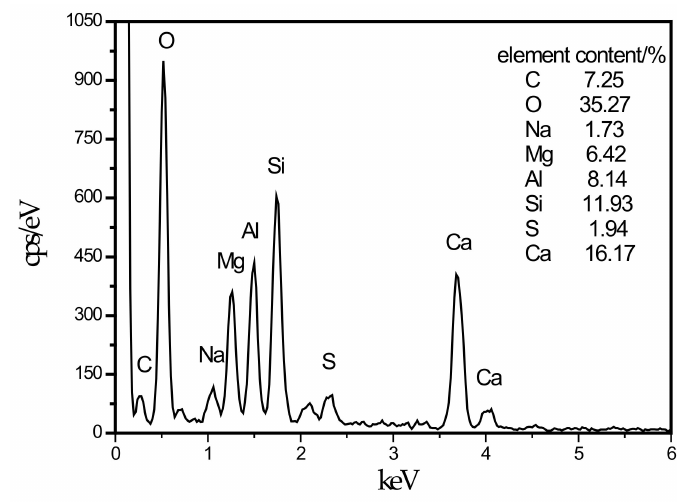
Figure 5. Energy dispersive spectrometry (EDS) energy spectrum of LDHs intimately intermix with the C–S–H.